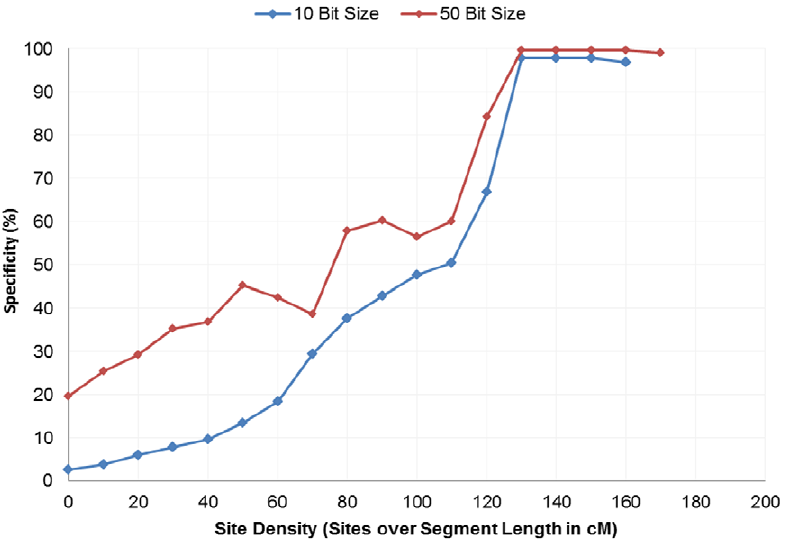
Figure 3. Exome specificity with varying exome site density. We see an increase in specificity of exome generated IBD segments in detecting data verified by GWAS IBD as we increase the threshold of site density.